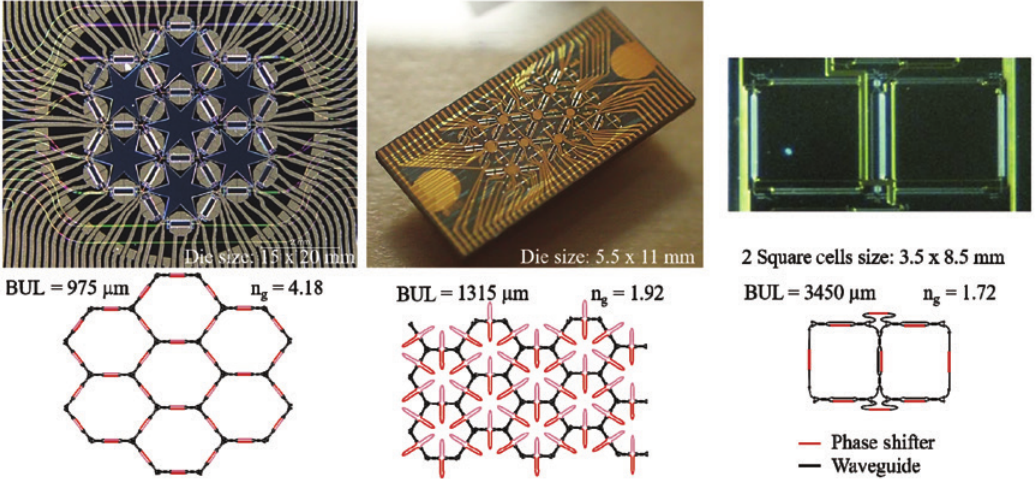
Figure 9: Chip picture and fabricated layout for different feedforward/backward waveguide meshes using different material platforms and cell